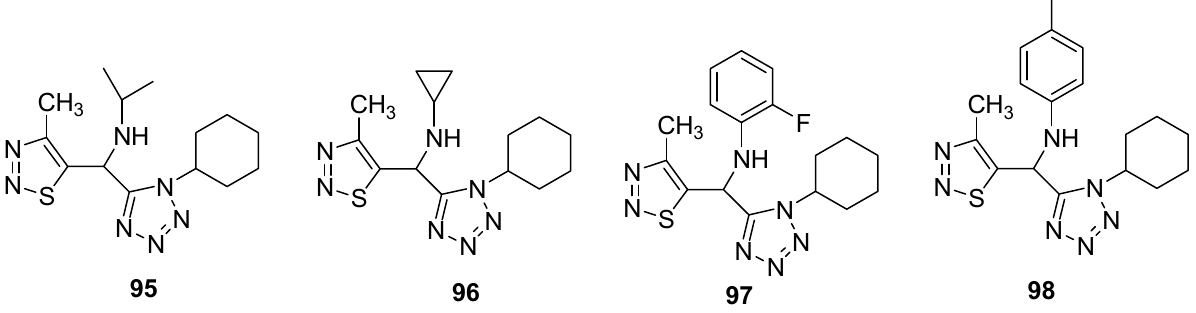
Figure 6. Antiviral activity of 1,2,3-thiadiazole 94 .